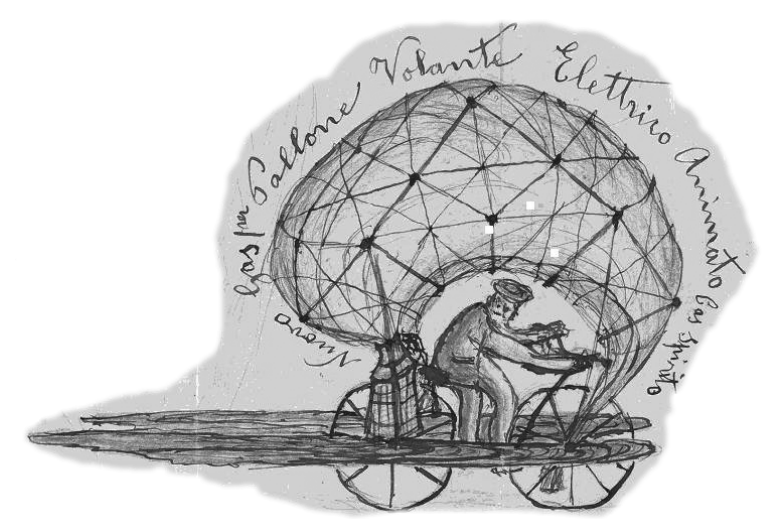
Fig. 1. Detail of a letter to T. Bertelli with the project for the gas-driven velocipide (Historical Barnabite Archives,